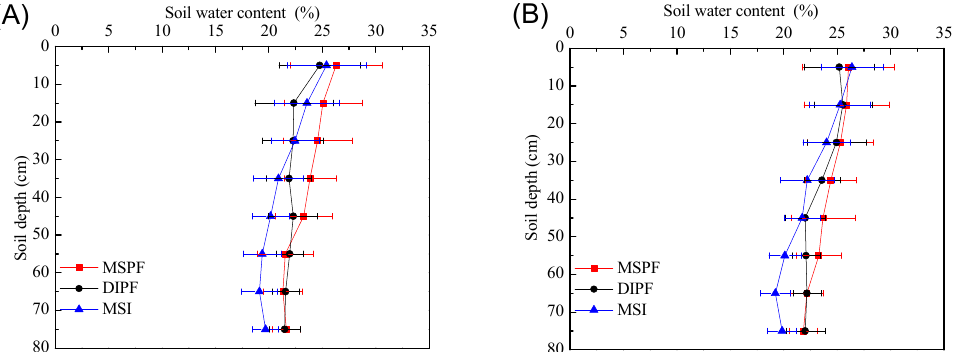
Figure 2. Average soil water content under different irrigation strategies during spring ( A ) and autumn ( B ).